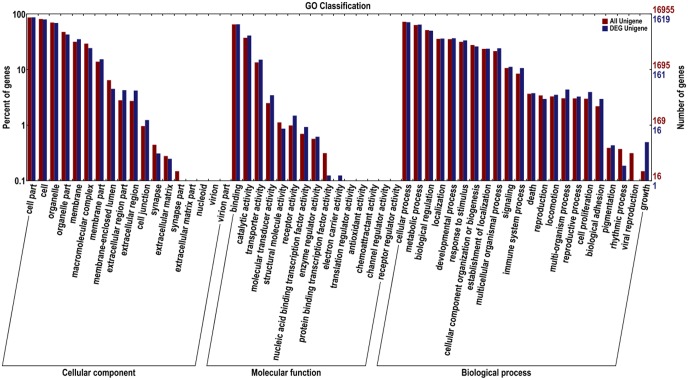
Functional annotation of sequences based on Gene Ontology (GO) categorization.